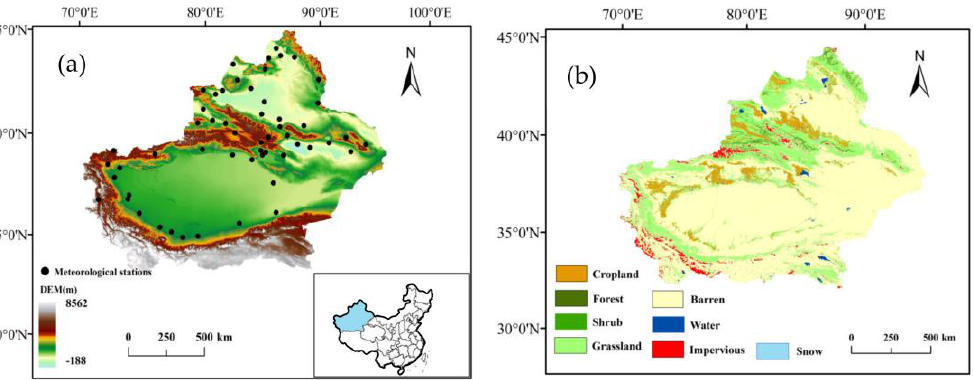
Figure 1. Map of the study area. ( a ) Elevation map and locations of meteorological stations. ( b ) Land cover map in 2010.